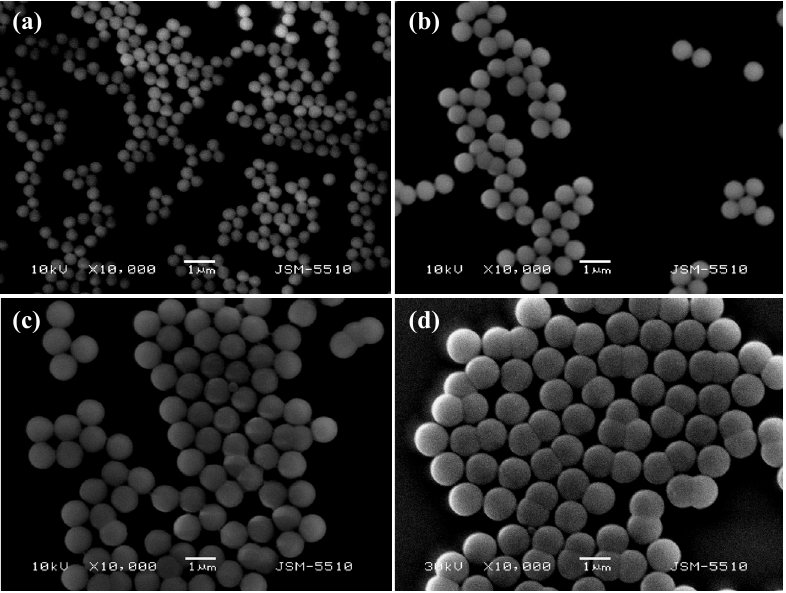
Figure 2: SEM micrographs of silica particles grown from (a) seeds with average diameter of 436 nm ± 5.0% to various particle sizes: (b) 638 nm ± 2.7% (third step of multistage growth), (c) 882 nm ± 2.2% (ninth step of multistage growth), and (d) 1041 nm ± 3.3% (the last fifteenth step of multistage growth)